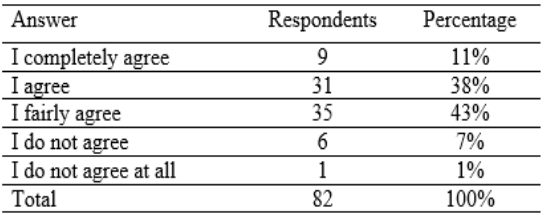
Table 3. Table of received answers to question